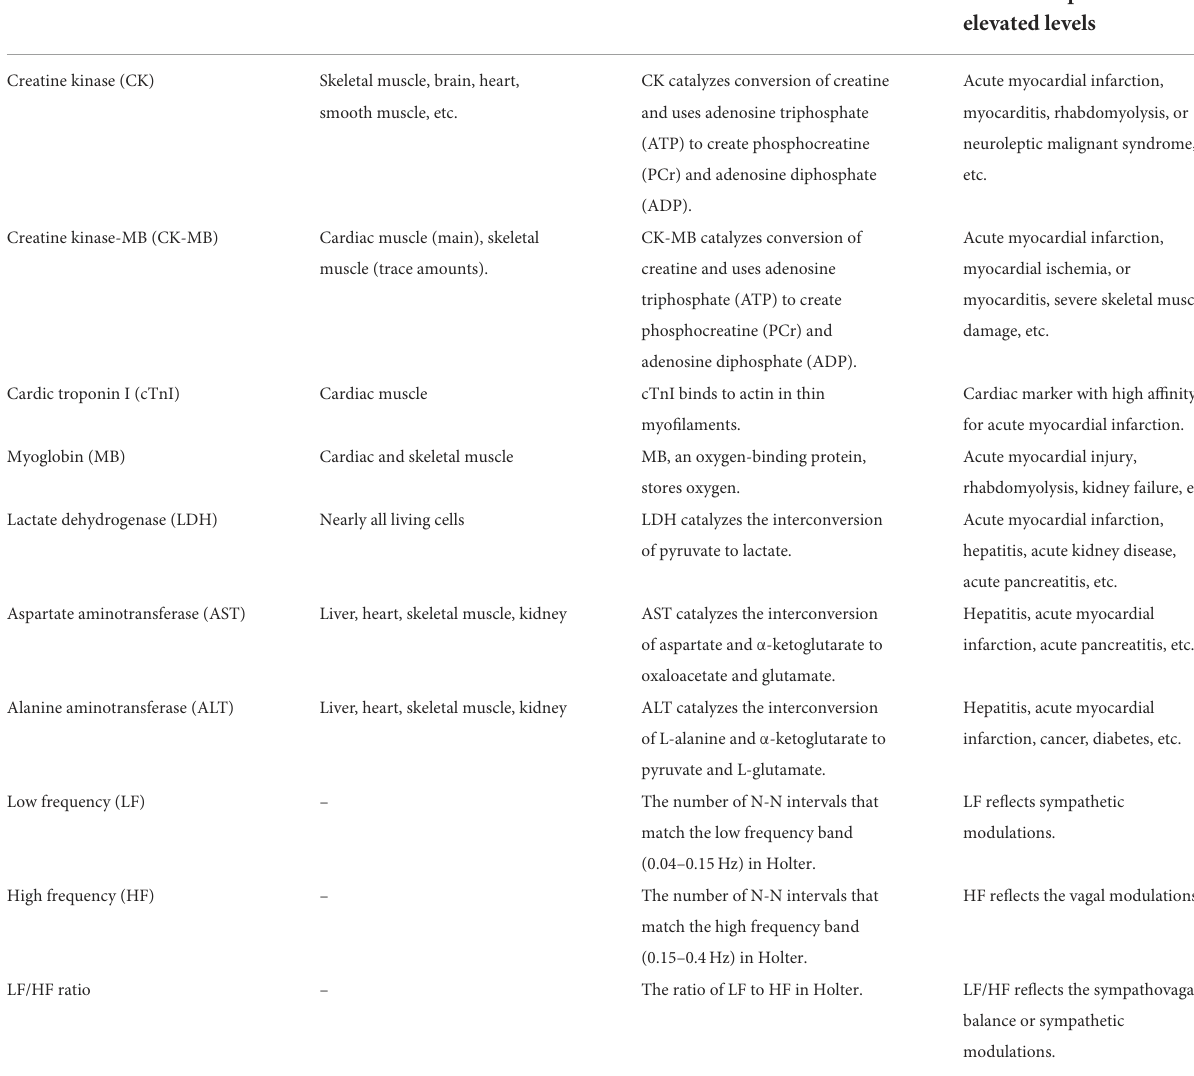
TABLE 2 Information on the relative